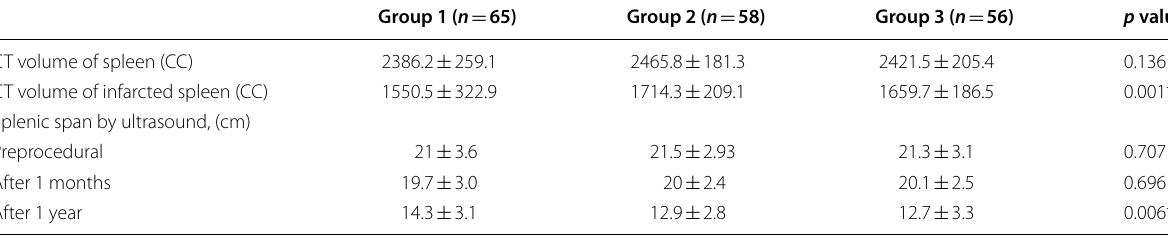
Data represent the mean